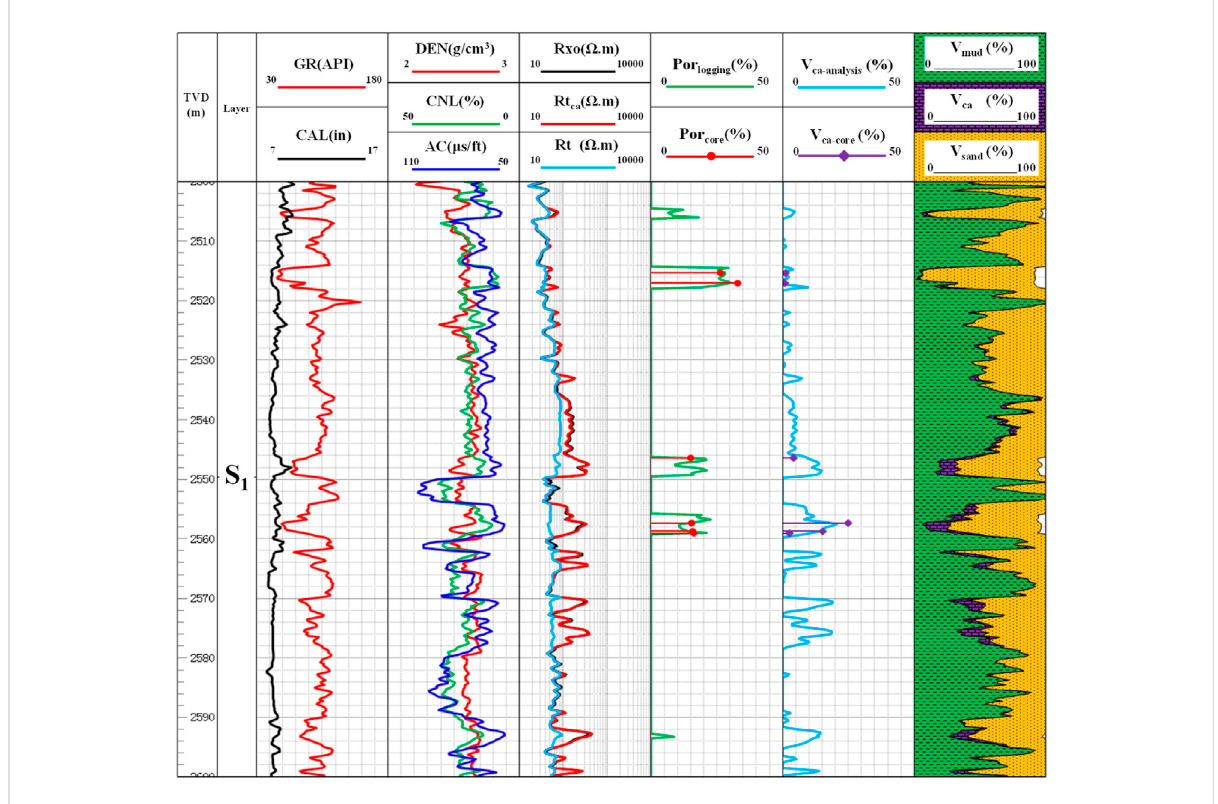
FIGURE 13 Resistivity correction of Well